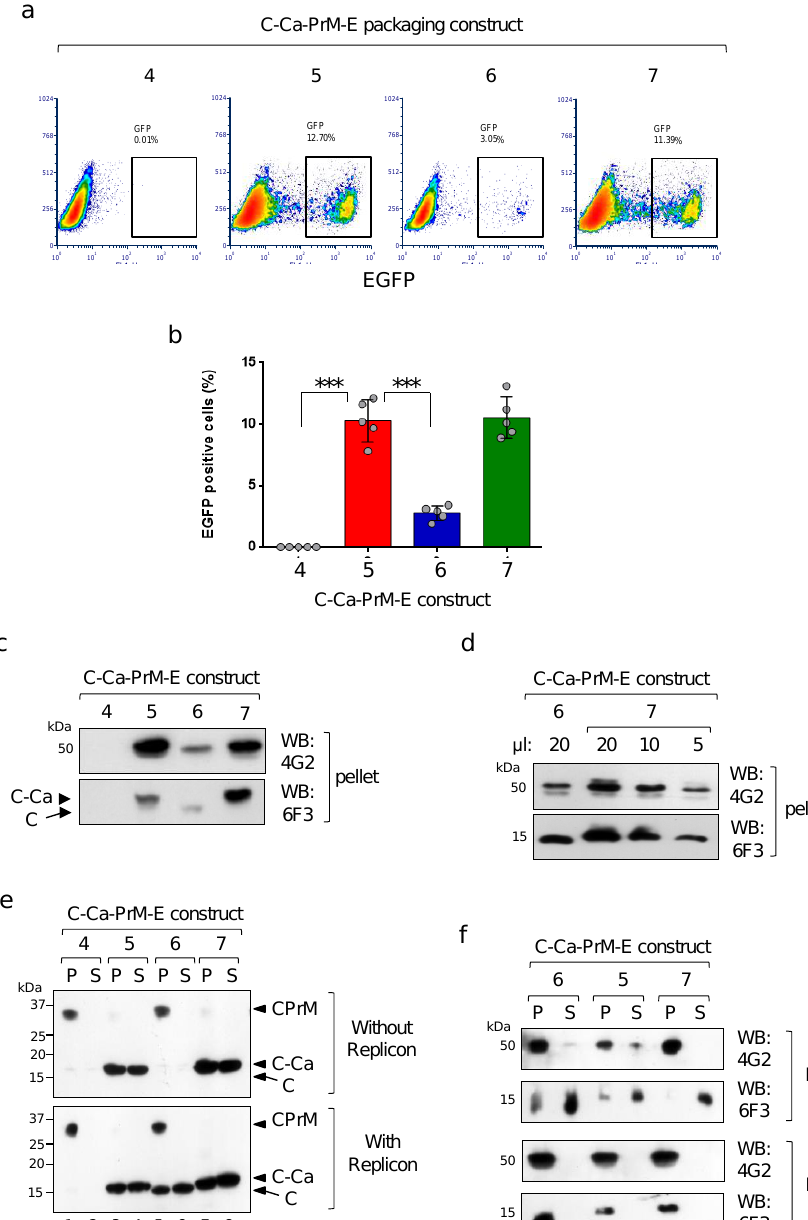
Figure 4. E ff ect of uncoupled sequential processing on viral infectivity. ( a ) Representative cytofluorimetry (EGFP) of VERO cells infected with the pseudoviruses produced with the indicated C-Ca-PrME packaging constructs. ( b ) Quantification of data shown in ( a ), ( N = 5). ( c ) Western blot of particles produced with the indicated constructs and recovered by ultra centrifugation, and analysed for content of protein E (mAb 4G2) and C (mAb 6F3). ( d ) Relative quantification of particles recovered with constructs 6 and 7. ( e ) Western blot of cellular extracts of cells co-transfected with the indicated packaging constructs and without (upper panel) or with (bottom panel) WNV replicon and extracted with sodium carbonate. Supernatants (S, soluble fraction) and pellets (P, membrane associated fraction) were analysed with mAb 6F3 to reveal processed and unprocessed isoforms. ( f ) Western blot of particles obtained with the indicated constructs and extracted with sodium carbonate (upper panel) or with control PBS (bottom panel). The distribution of the two proteins E and C, in the two fractions (S, soluble and P, membrane associated) were analysed with mAbs 4G2 and 6F3,